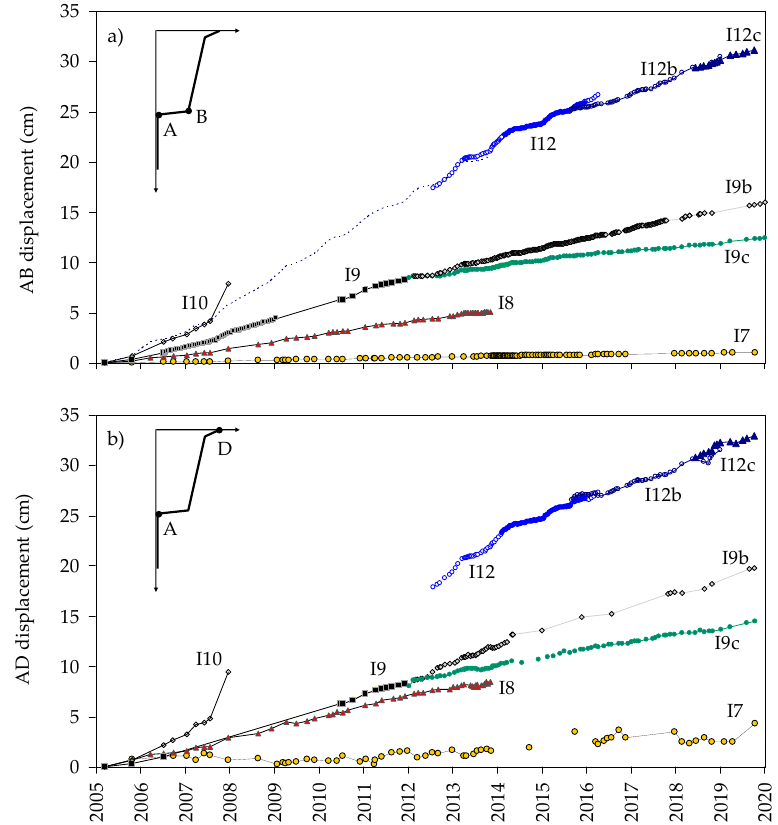
Figure 5. Time series of cumulative deep displacements AB ( a ) and superficial displacements AD ( b ) of Costa della Gaveta landslide, obtained from inclinometer data.